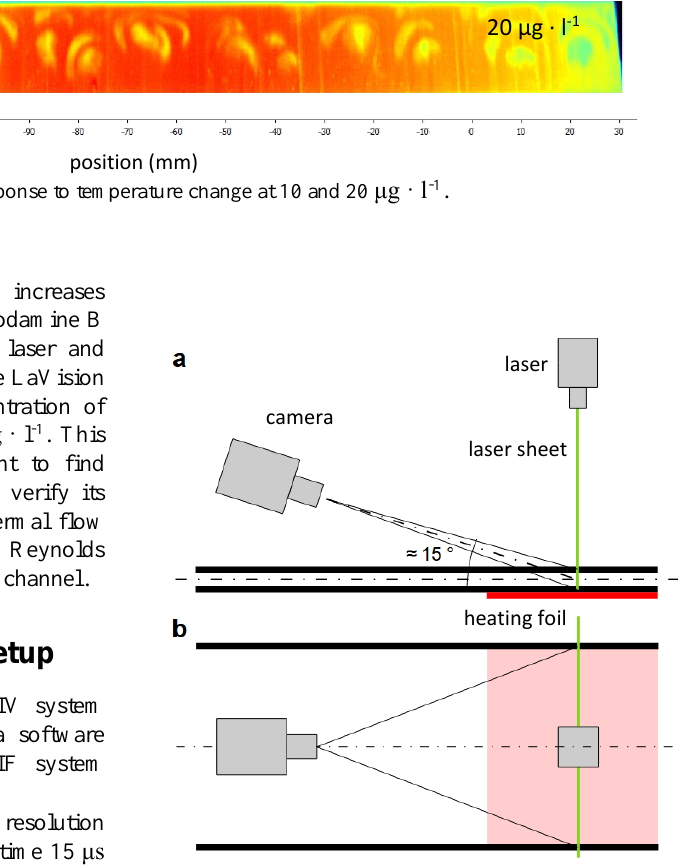
Fig. 1. Scheme of the experimental setup; a side view, b top view.